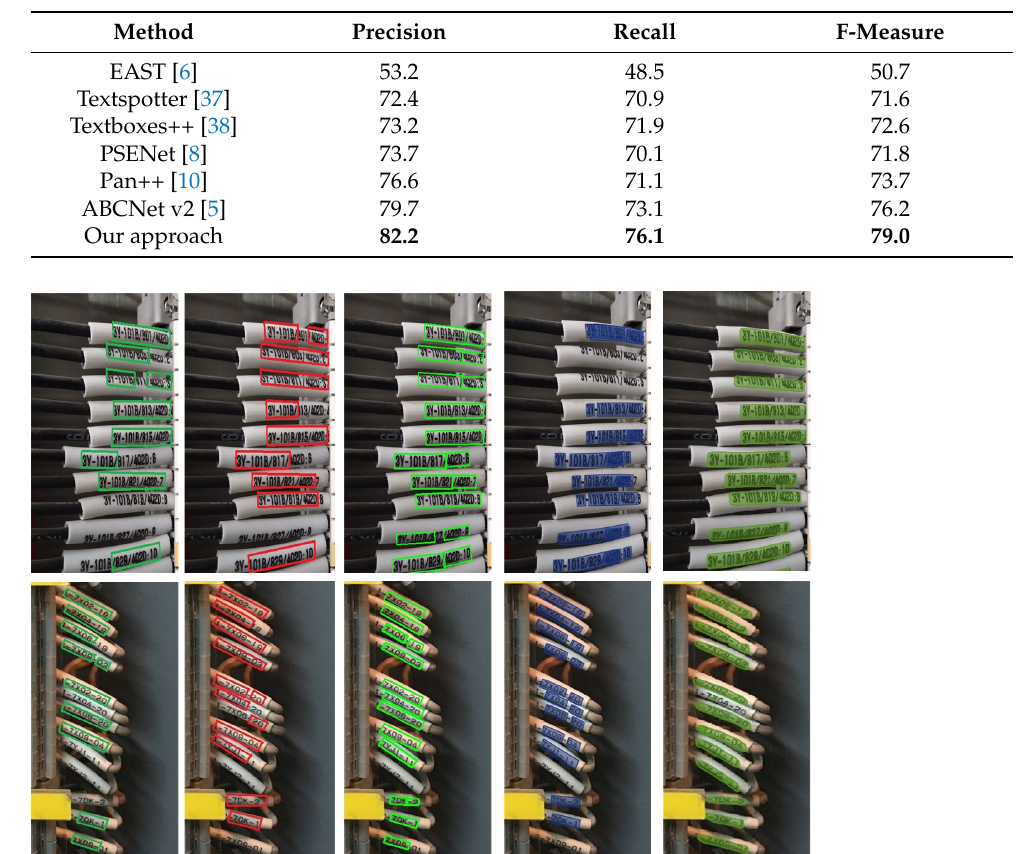
Table 1. Detection comparison with state-of-the-art methods on our dense scene text dataset.